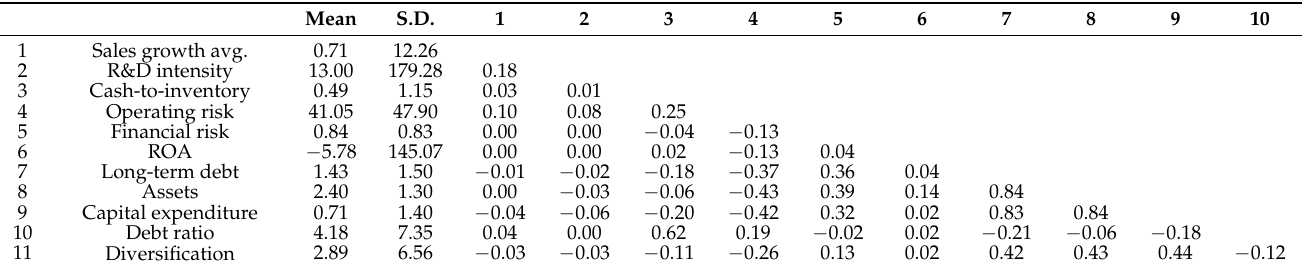
Table 1. Pairwise correlations